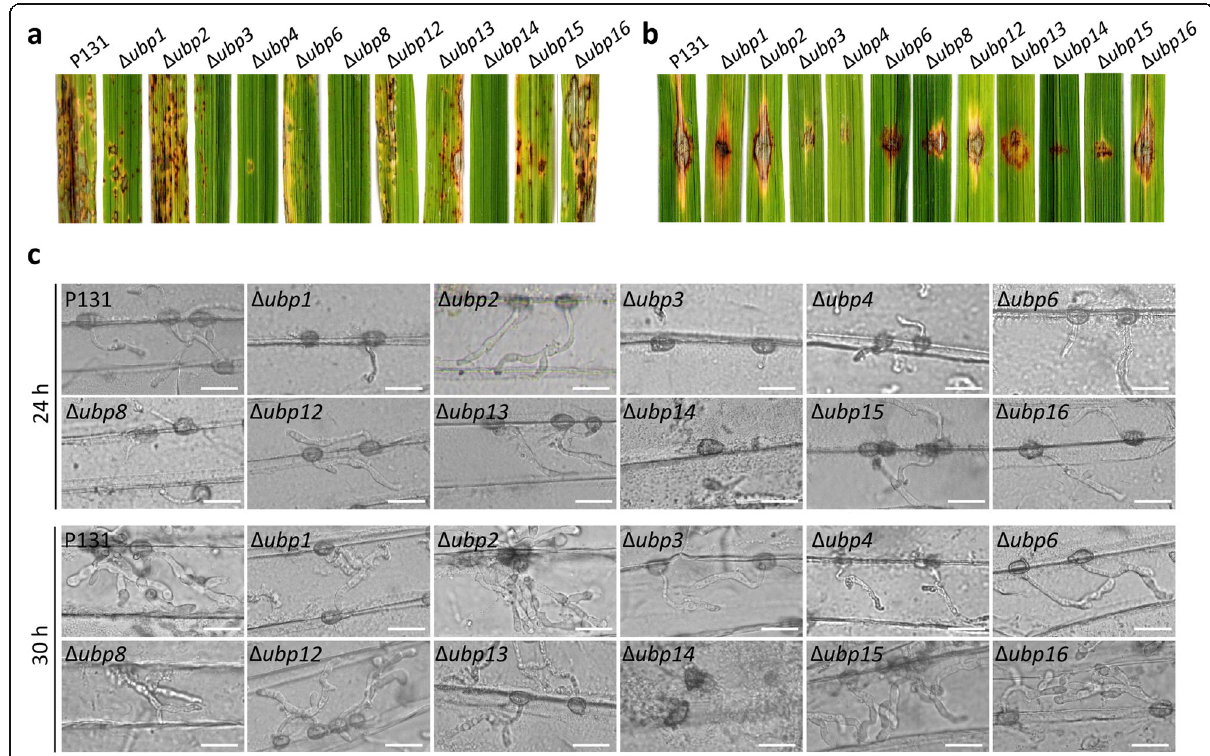
Fig. 6 Pathogenesis of the ubp mutants. a Lesions formed on rice leaves sprayed with conidia of the wild-type and ubp mutant strains at 5 dpi. b Lesions formed on the wounded rice leaves inoculated with mycelial agar plugs of the wild-type and ubp mutant strains. c Invasive hyphae formed in barley epidermal cells at 24 hpi and 30 hpi. Bar, 20 μ